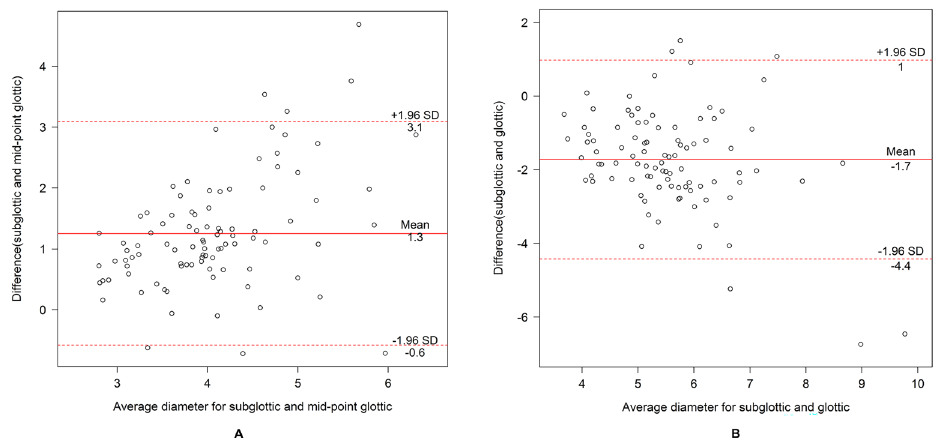
Figure 5. Bland–Altman plots of subglottic diameter-mid-glottic diameter ( A ) and subglottic diameter-glottic diameter ( B